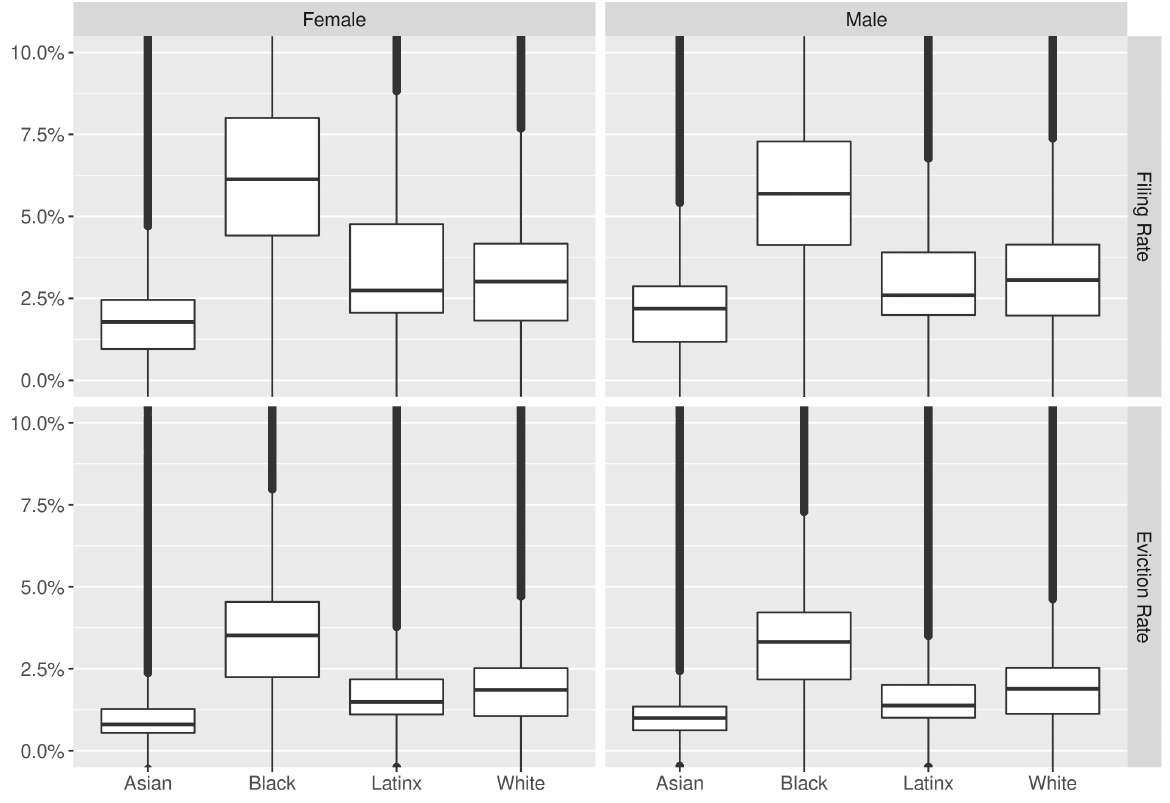
Figure 2: Distributions of eviction filing rates and eviction rates, by gender and race/ethnicity. Note: Data are presented as box and whisker plots, displaying distributions through five statistics: the median (the horizontal line within the white box for each state), the 25th and 75th percentiles (which form, respectively, the lower and upper bounds of each box), and two whiskers. Whiskers extend no more than 1.5 times the interquartile range (the distance between the first and third quartiles). Rates beyond the range of the whiskers are considered outliers and are plotted as individual